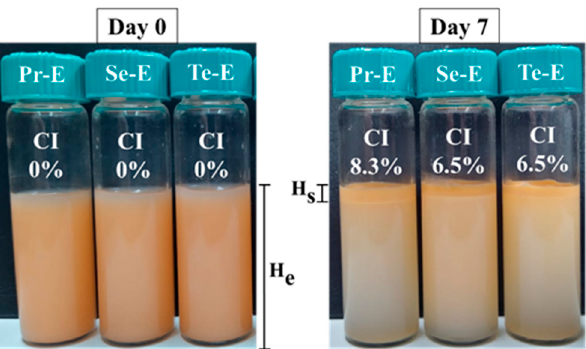
Figure 4. Evolution of Creaming Index (CI) (%) of Pr-E, Se-E, and tertiary emulsion (Te-E), during 7 days of storage at 25 °C. 7 days of storage at 25 ◦